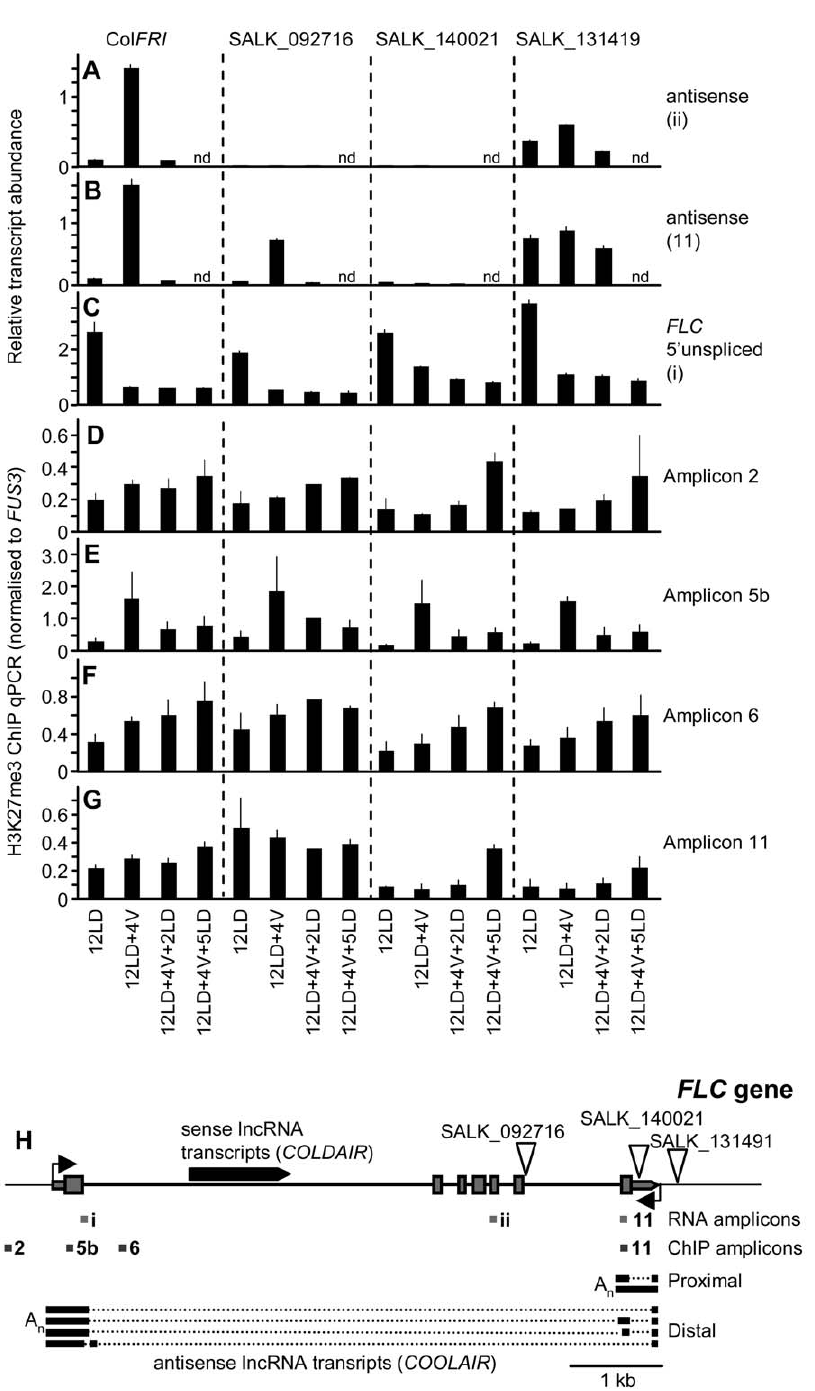
Figure 2. COOLAIR lncRNAs are not required for cold-repression of FLC . A, B and C) qPCR quantification of antisense (A, B), and FLC 5 9 unspliced transcript (C) is shown for Col FRI , SALK_092716, SALK_140021 and SALK_131491 for plants grown for 12 long days in warm conditions (12LD), 12 days in warm and transferred to cold conditions for 4 weeks (12LD + 4V) or cold treated then returned to warm conditions for 2 or 5 days (12LD + 4V + 2LD, 12LD + 4V + 5LD). D, E, F and G) H3K27me3 ChIP-qPCR for amplicon 2 (D), amplicon 5b (E), amplicon 6 (F) and amplicon 11 (G) in Col FRI and T-DNA insertion lines. H) Diagram of FLC gene, triangles mark T-DNA insertion sites. n.d.; not determined.